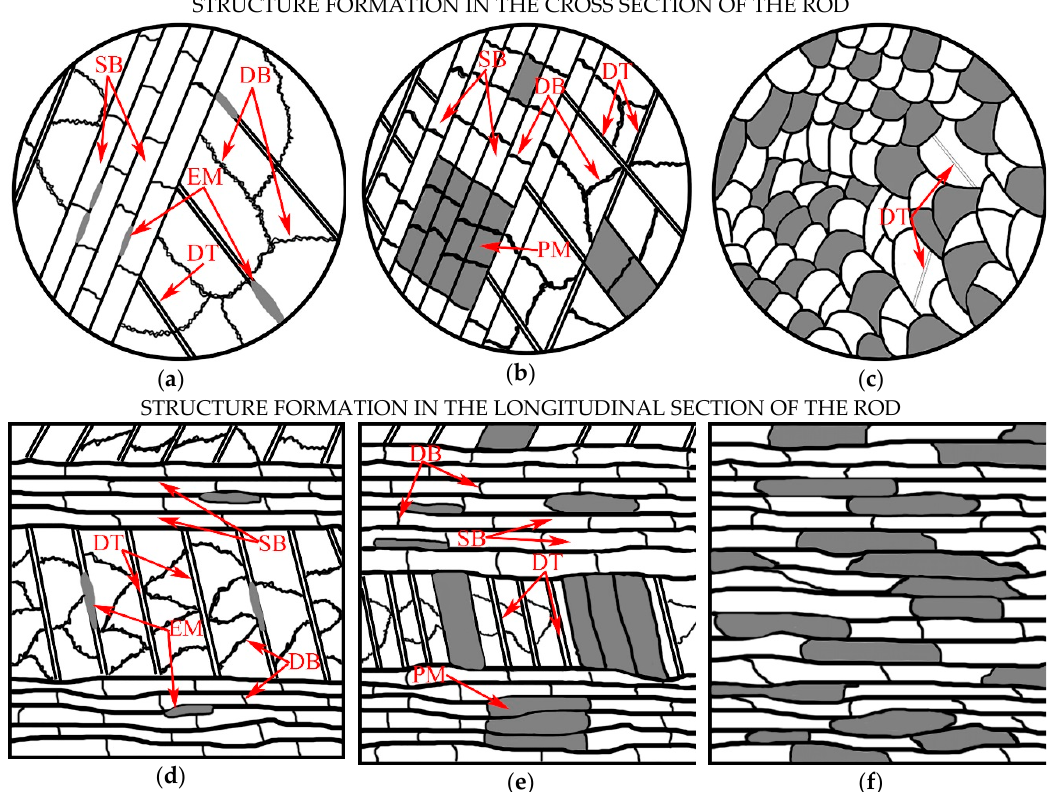
Figure 9. Scheme of the 321 MASS structure formation of the rod: ( a , d ) First stage; ( b , e ) Second stage; ( c , f ) Third stage. Note: white color: austenite; grey color: martensite; DB: dislocation boundary; DT: deformation twin; SB: shear band; EM: embryo of martensite; PM: packages of